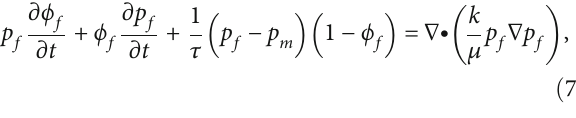
protected layer at di ff erent 19